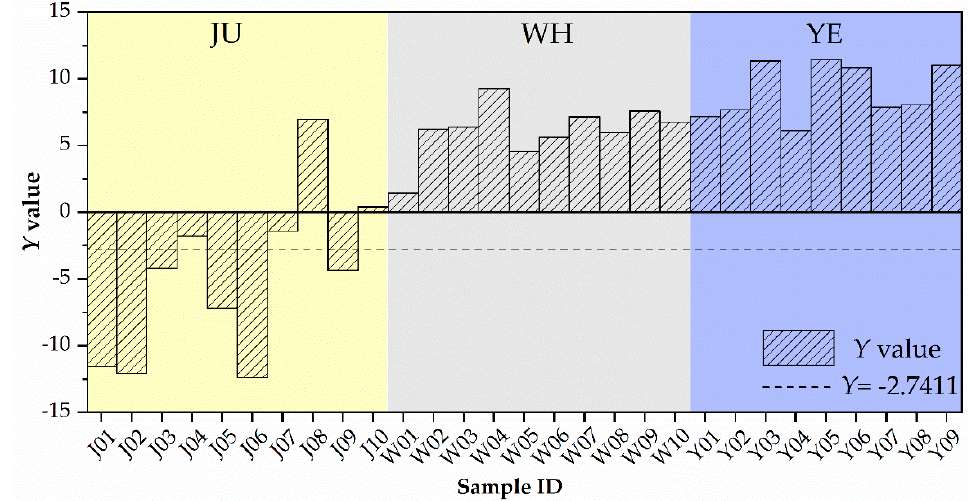
Figure 5. The discriminant parameter value ( Y ) of plinthosol in the JU, WH, and YE profiles.